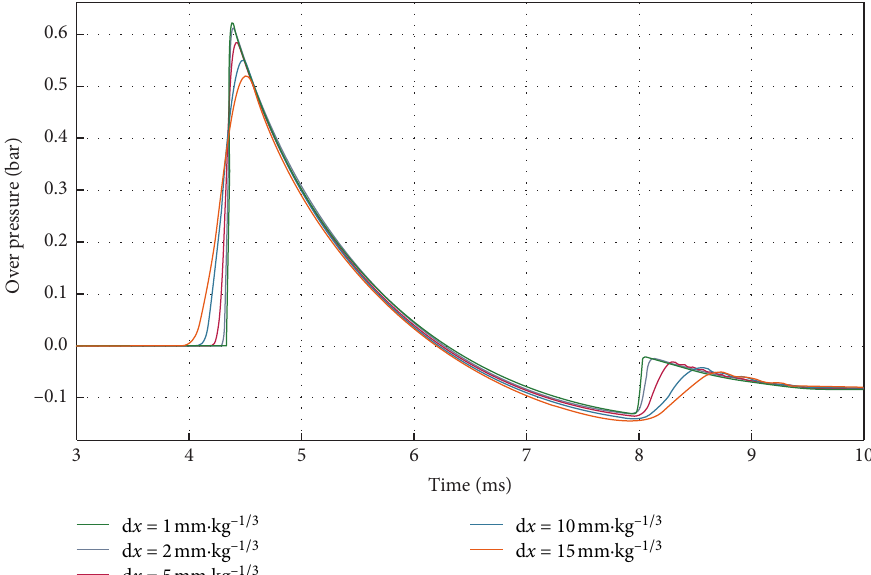
Figure 13: Overpressure at 3m · kg − 1 / 3 for beta � 3, obtained with various reduced mesh